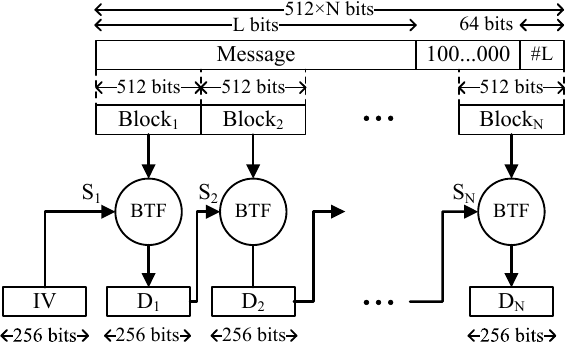
Figure 3: Details of the SHA256 function. BTF stands for the block transform